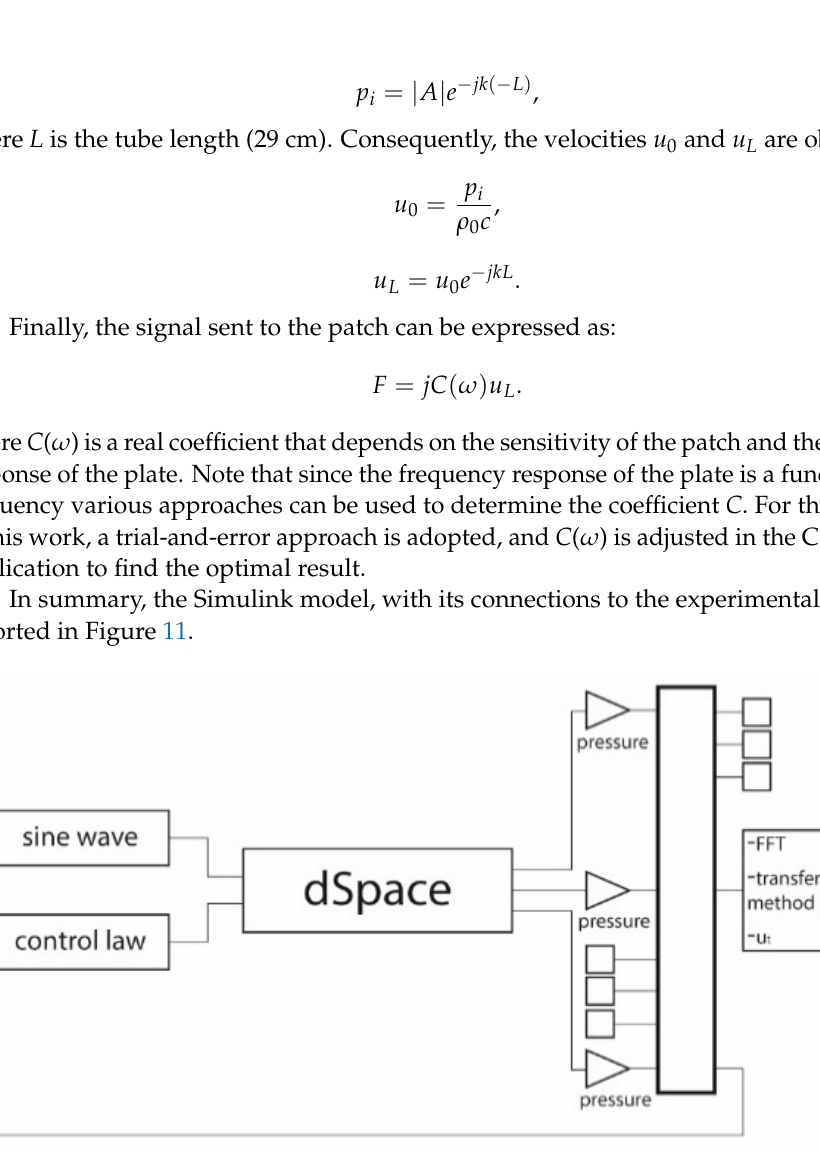
Table 2. Experimental reflection coefficients in the active case.